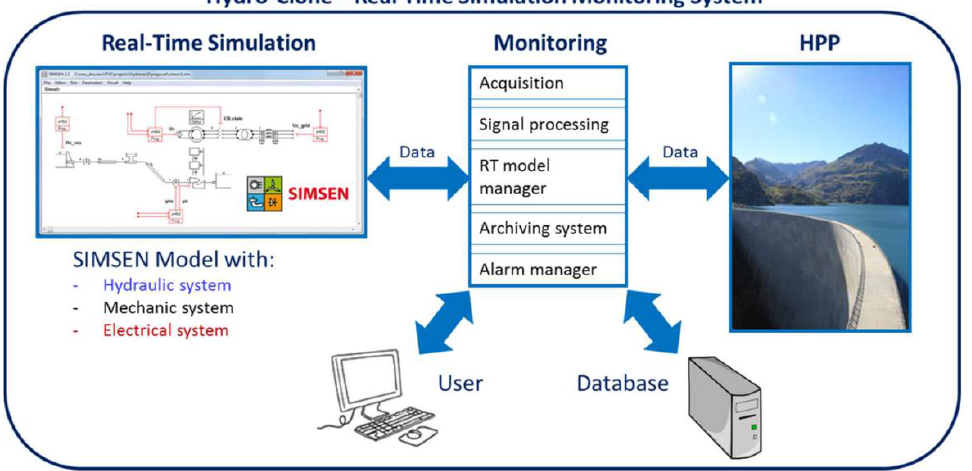
Figure 14. Concept of the Hydro-Clone system based on continuous monitoring of parameters linked with a real-time simulation [104].